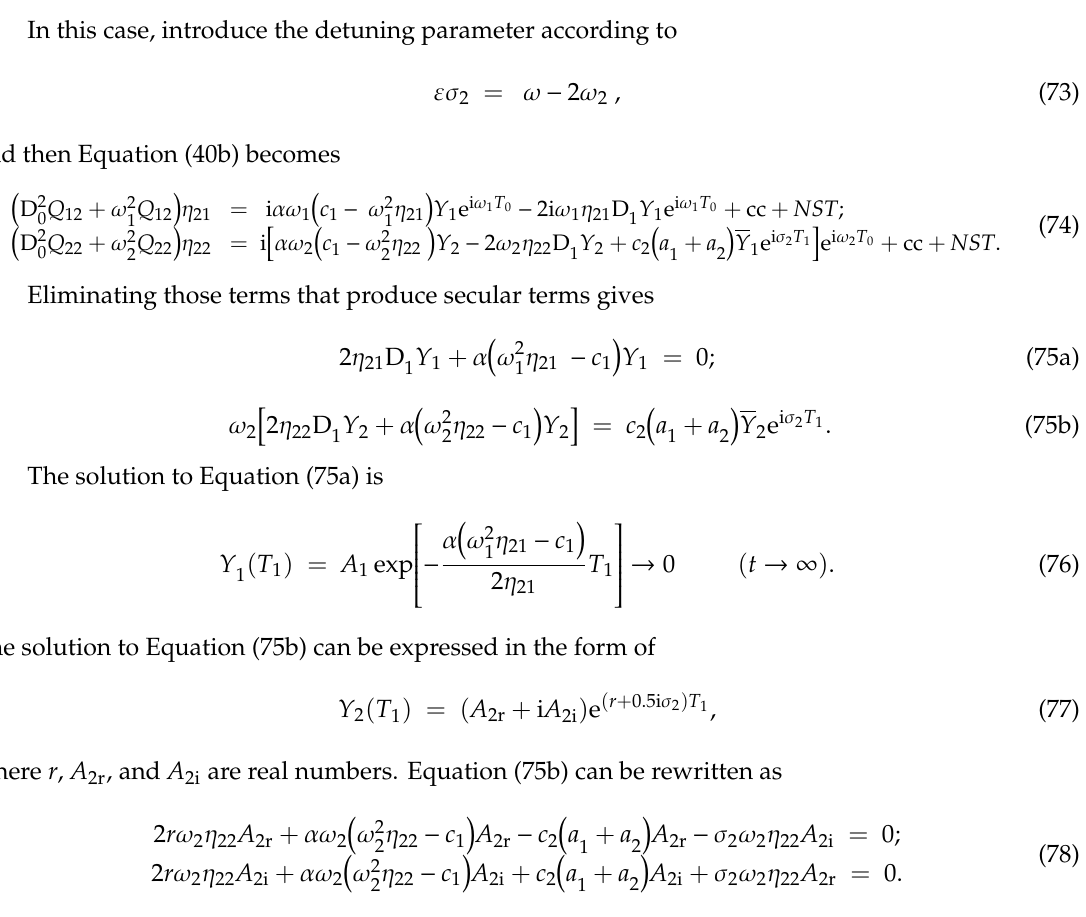
Figure 9. The period-doubling motion when ω = 2 ω 1 : ( a ) initial history; ( b ) steady-state response; ( c ) phase diagram; ( d ) Poincare map.